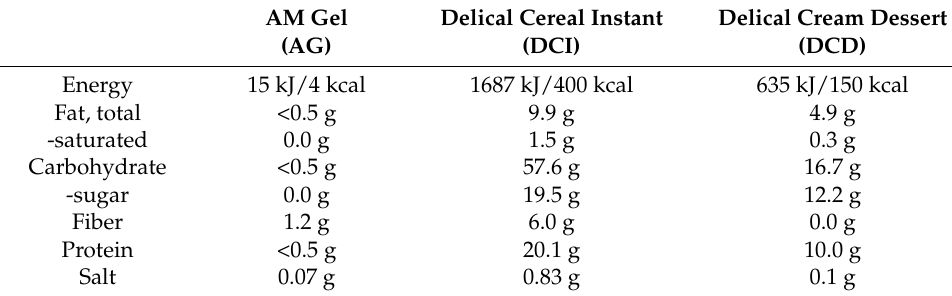
Table 1. Nutrition facts (g/100 g of product) of commercial